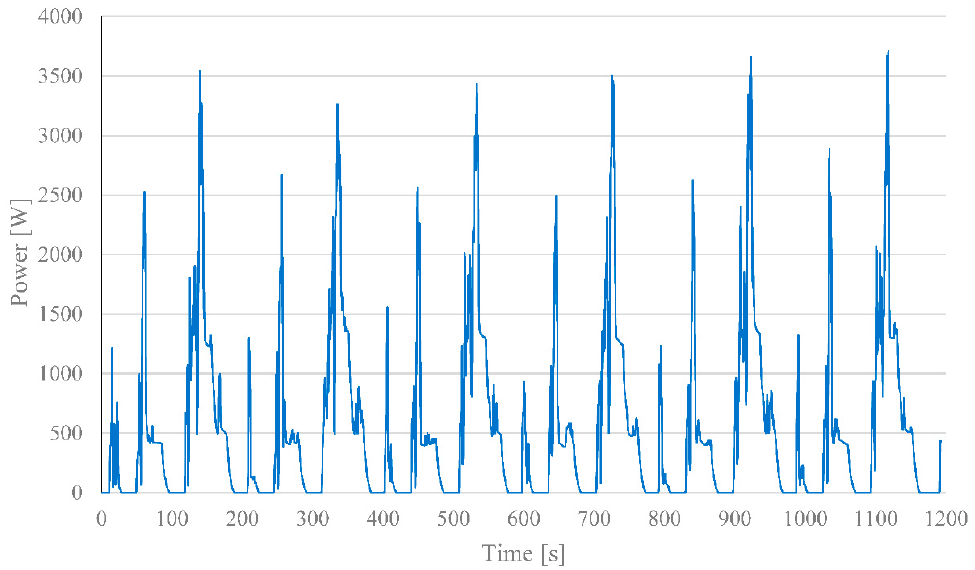
Figure 5. Estimated global power requirements during the UDC driving cycle. Table 2. Power and energy requirements of the tested motorcycle during the UDC driving